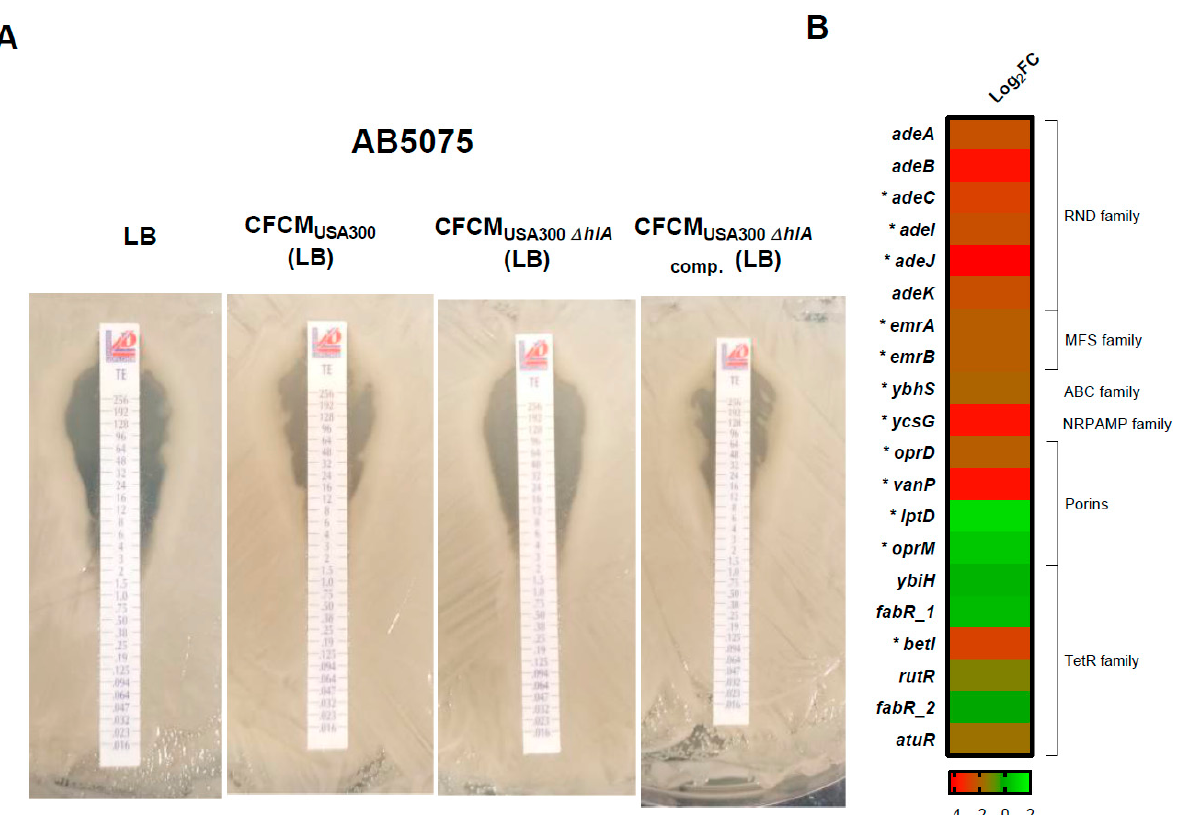
Figure 4. Phenotypic and transcriptomic analysis of antibiotic resistance coding genes. ( A ) Minimum inhibitory concentration (MIC) was performed by E-test (Liofilchem, Italy) following CLSI recommendations for A. baumannii AB5075 in presence or absence of different CFCM. ( B ) Heatmap showing the differential expression of genes associated with antibiotic resistance. DEG are indicated with an asterisk (FDR <